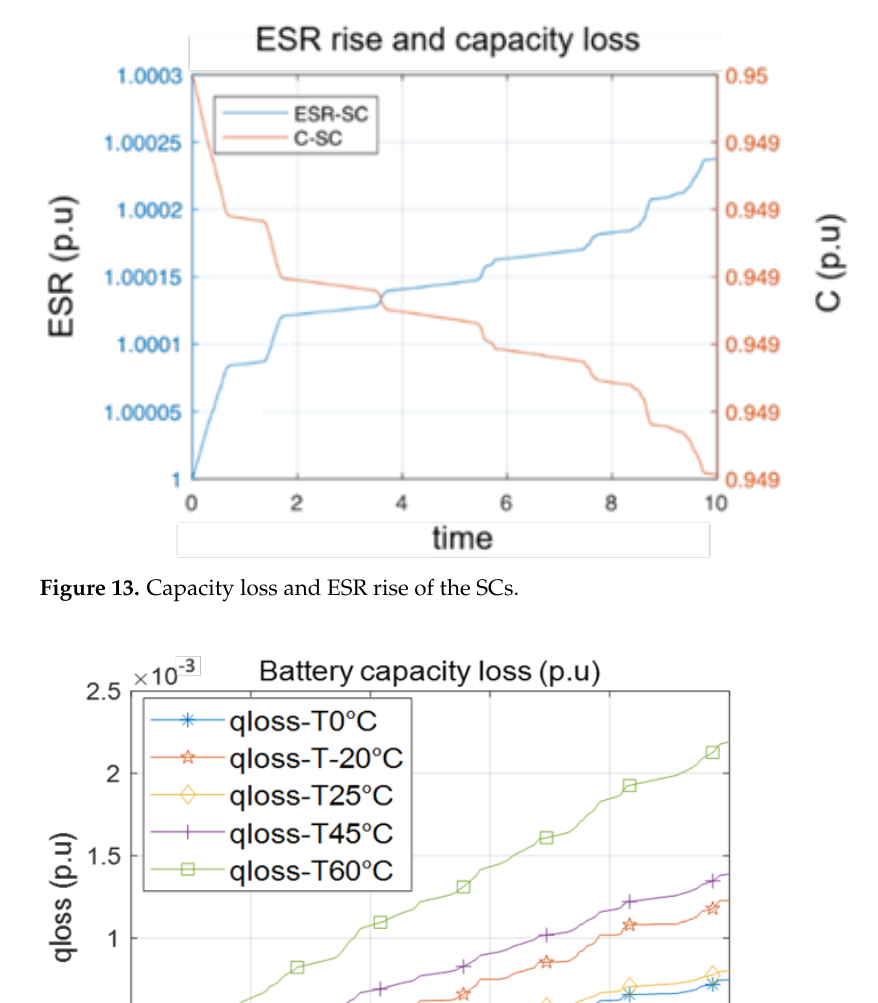
Figure 13. Capacity loss and ESR rise of the SCs.